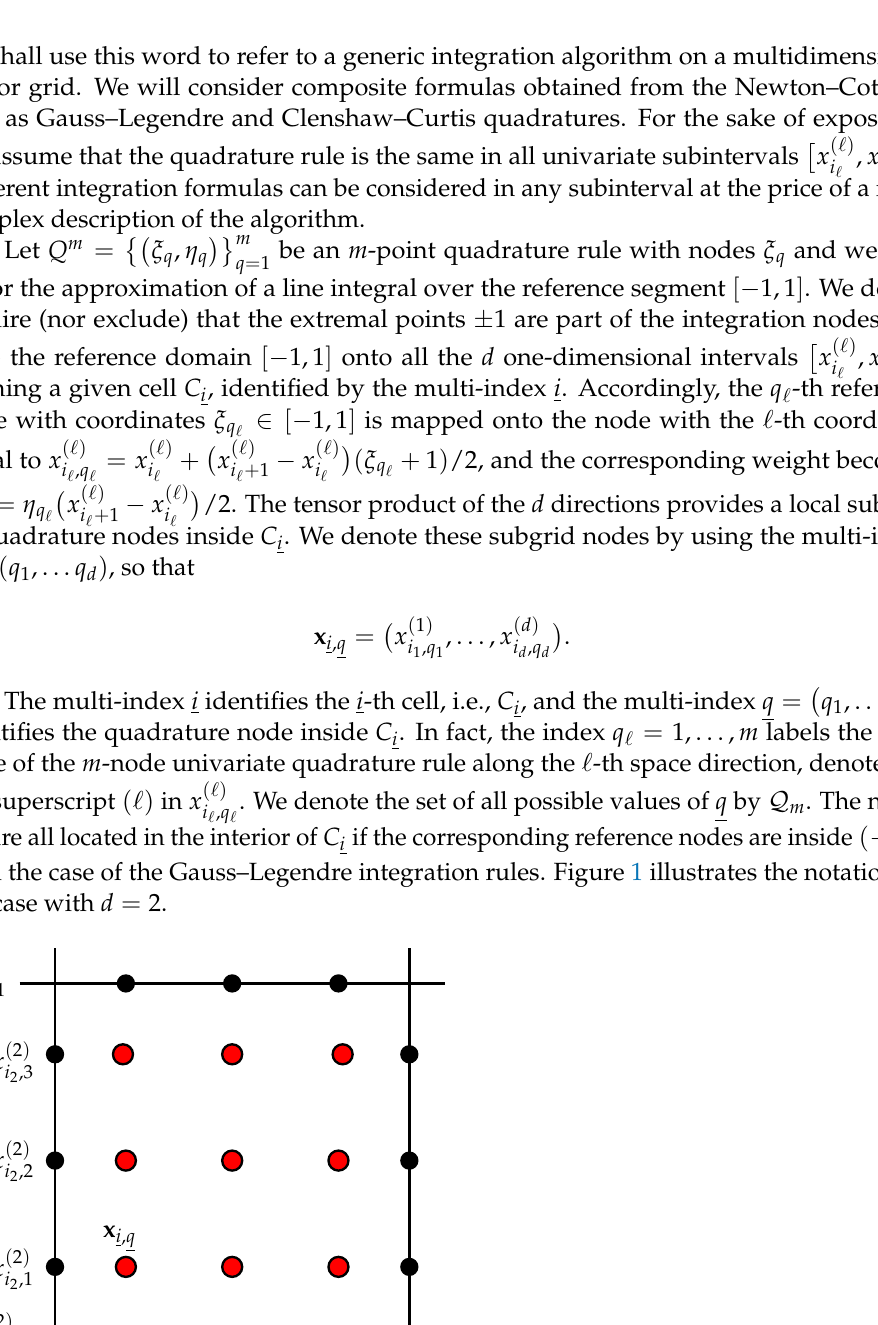
Figure 1. Notation. For d = 2, we show the generic cell C i = with i = ( i 1 , i 2 ) ; the univariate quadrature nodes (black dots) with coordinate x (cid:96) = 1,2, q (cid:96) = 1,2,3, which corresponds to the 3-point Gauss–Legendre integration rule; the cu- bature nodes inside the cell (red dots) are provided by the tensor product of the one-dimensional quadrature nodes along the directions (cid:96) = 1,2. To make the figure easily readable, we show all the quadrature and cubature nodes relative to cell C i , but we report only the coordinates of the quadrature nodes at the bottom and left sides, and the coordinates of the internal bottom-left node, i.e., x i , q , with i = ( i 1 , i 2 ) , and q = ( 1,1 )